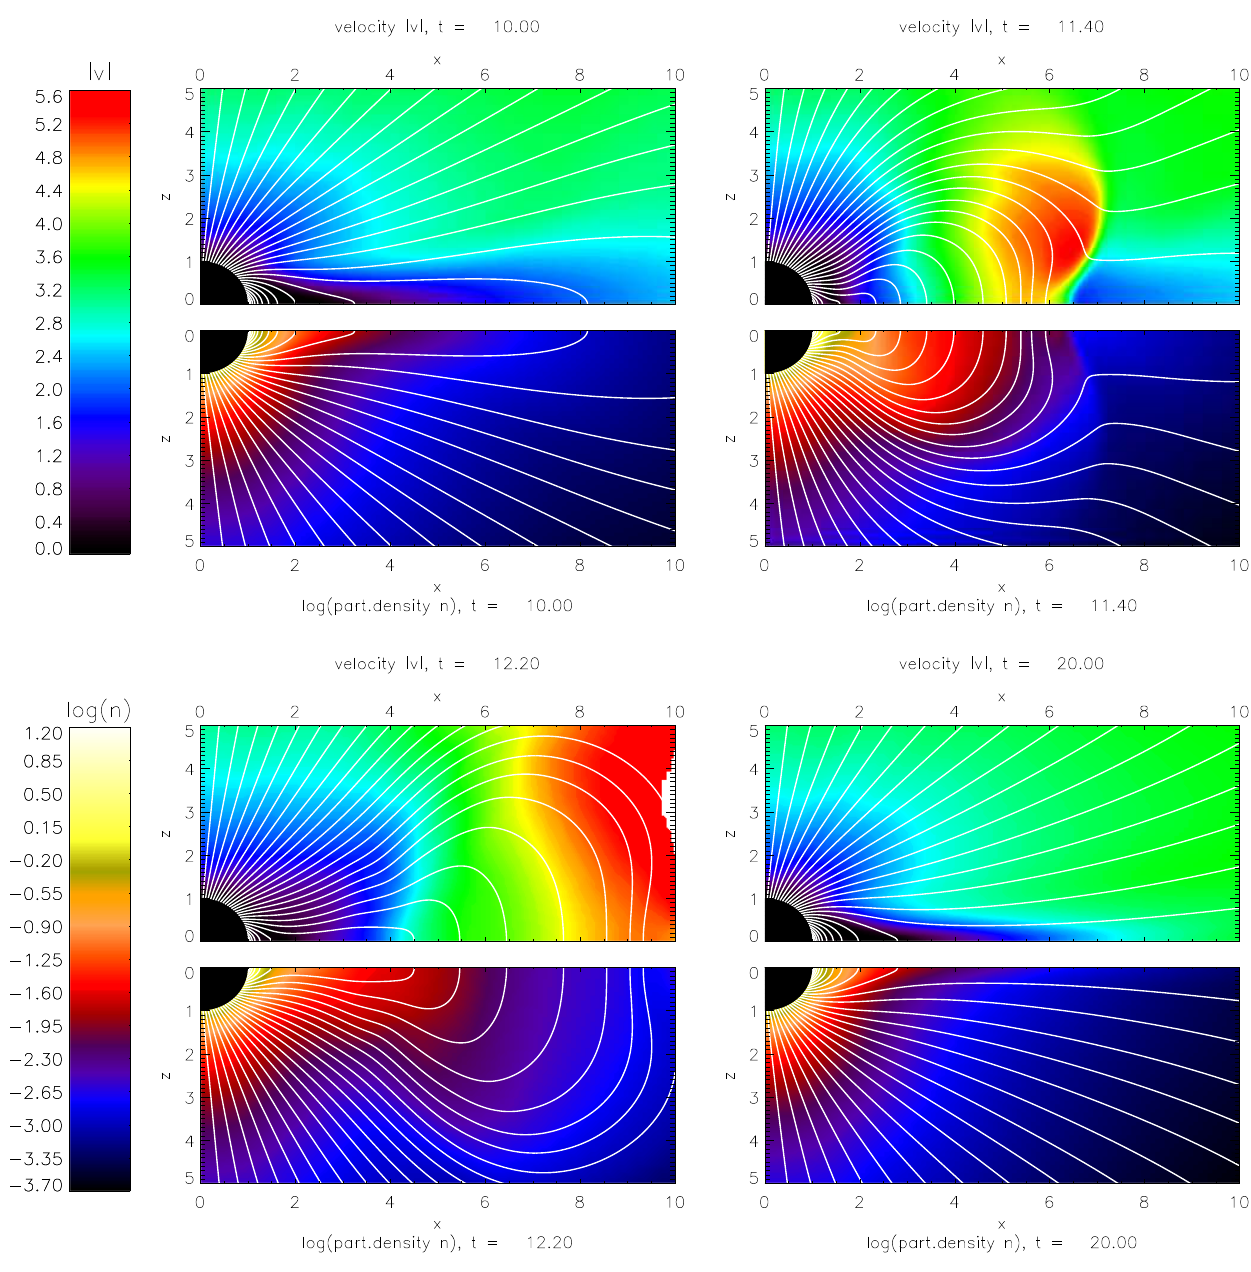
Fig. 6. Time sequence of simulated CME expansion from pre-eruption ( t = 10 . 0) to expansion and return to equilibrium (at t = 20 . 0), showing contours of k u k (top) and log 10 n (bottom) in the poloidal plane ( y = 0), with magnetic field lines superimposed. The CME speed at onset was chosen to be u cme = 2. An MPEG movie of this simulation, which covers the entire simulation from initialization ( t = 0) to convergence into steady-state (near t = 10), CME expansion and back to near-equilibrium ( t ≈ 20), is available from the supplementary material at